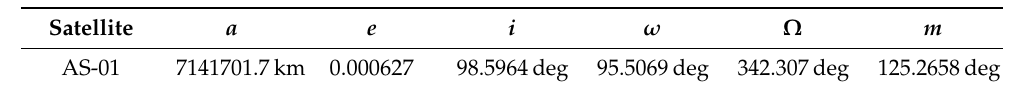
Table 2. Satellite orbit